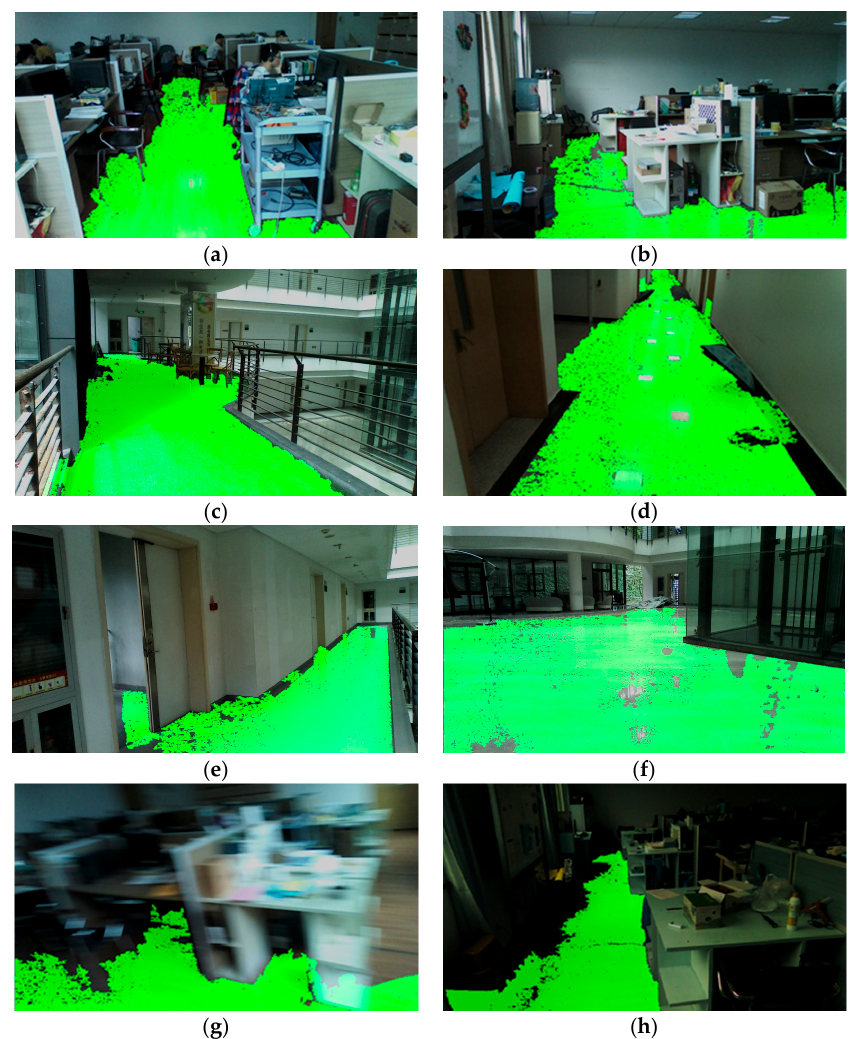
Figure 8. Results of traversable area expansion in indoor environment. ( a , b ) Traversable area detection in offices; ( c – e ) traversable detection in corridors; ( f ) traversable area detection in an open area; ( g ) traversable area detection with color image blurring; abd ( h ) traversable area detection with color image under-exposing.